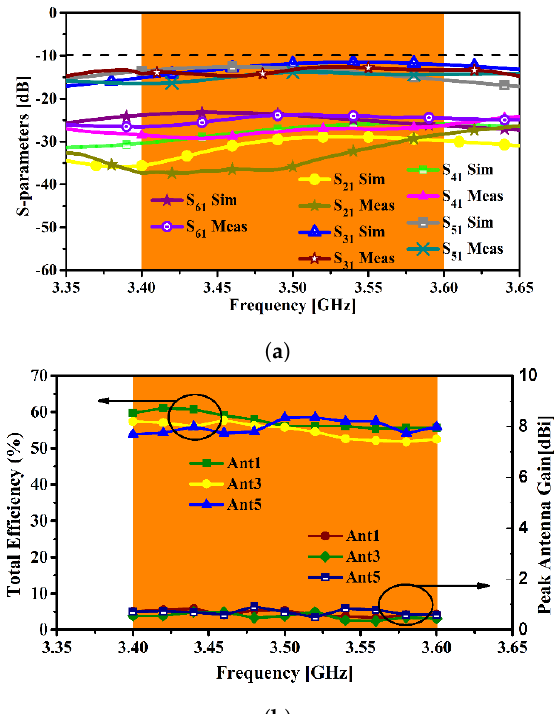
Figure 6. ( a ) The measured and simulated S-Parameters for port isolation. ( b ) Measured gain and total efficiency for Ant1, Ant3, and